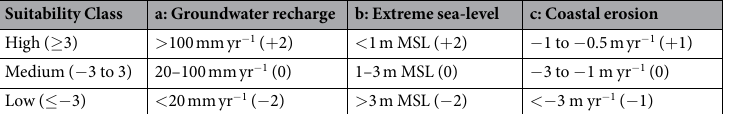
Table 1. Weights assigned to (a) groundwater recharge, (b) extreme sea-levels, and (c) coastal erosion, which combined result in the suitability (low, medium, high) of eroding sandy shores for a growth of fresh groundwater resources by large beach